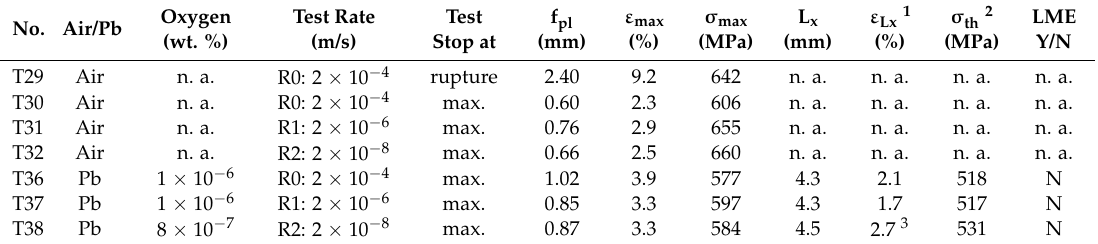
Table 3. Results of CERT testing with tapered specimens at 400 ◦ C in air and liquid Pb. f pl : the